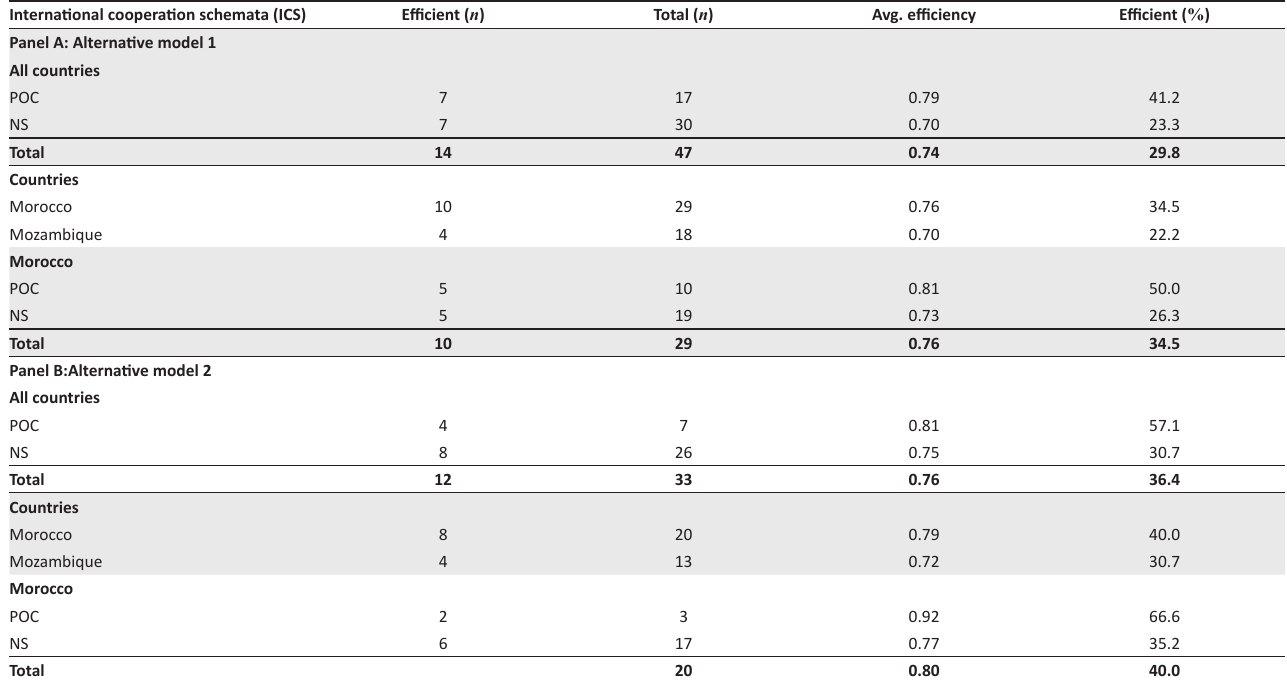
Table 1-A2: Summary of DEA: Alternative models